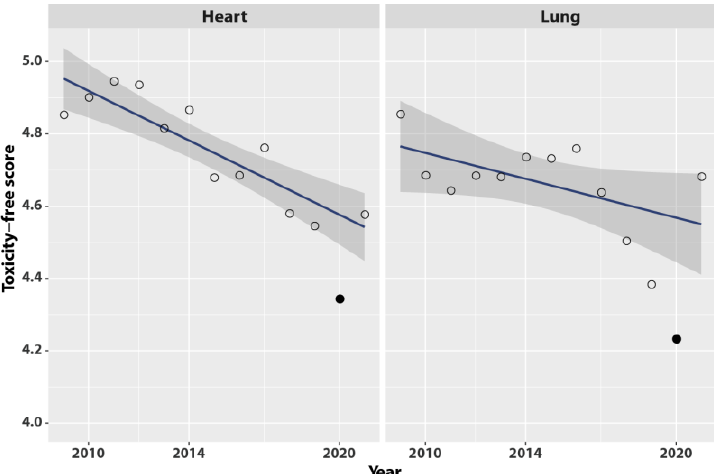
Figure 2. The effect by year on heart and lung toxicity-free scores. Continuous toxicity-free score scaled from 1 (worst, no freedom from toxicity) to 5 (best, fully free of toxicity), where score = (5 — Grade). Open circle: score averaged on all patients observed in the year. Filled circle: score observed in 2020, year of the COVID pandemic. Line: ordinary least squares fitted on years 2009 – 2021 exclud- ing 2020. Grey band: 95% confidence interval of the least squares fit.